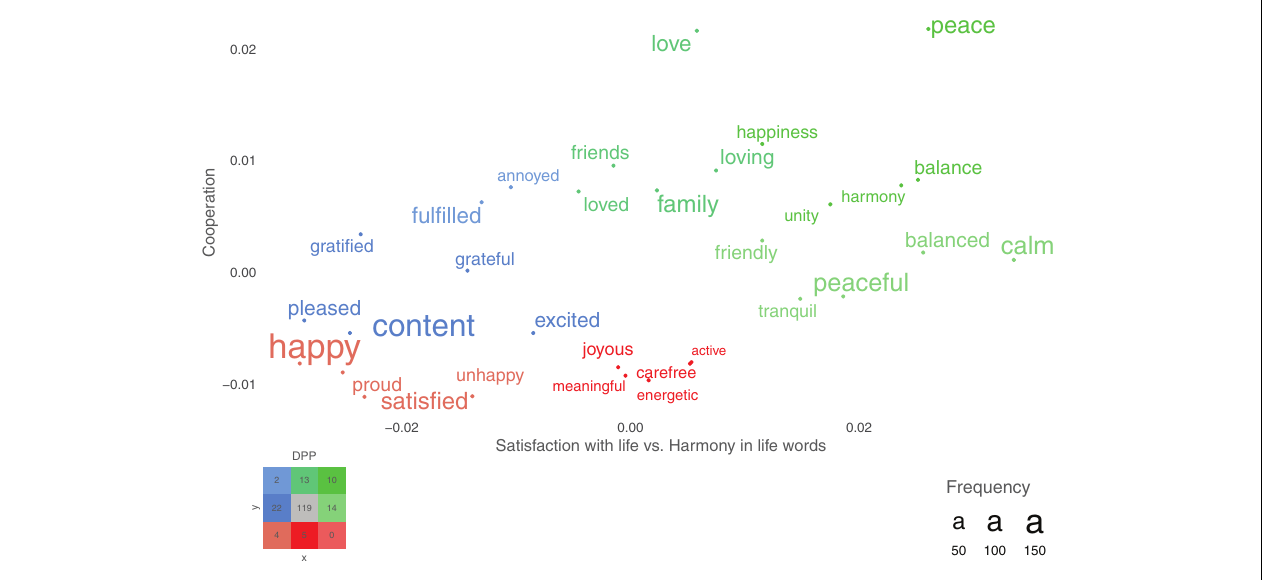
FIGURE 2 | A supervised dimension projection plot of words significantly differing between responses to the satisfaction with life and the harmony in life ( x -axis) and the level of cooperation ( y -axis). The colored legend in the lower left corner indicates the color and number of significant words in each part of the figure (for example, there are 10 light green words that are significantly high on both the x -axis and y -axis). N =